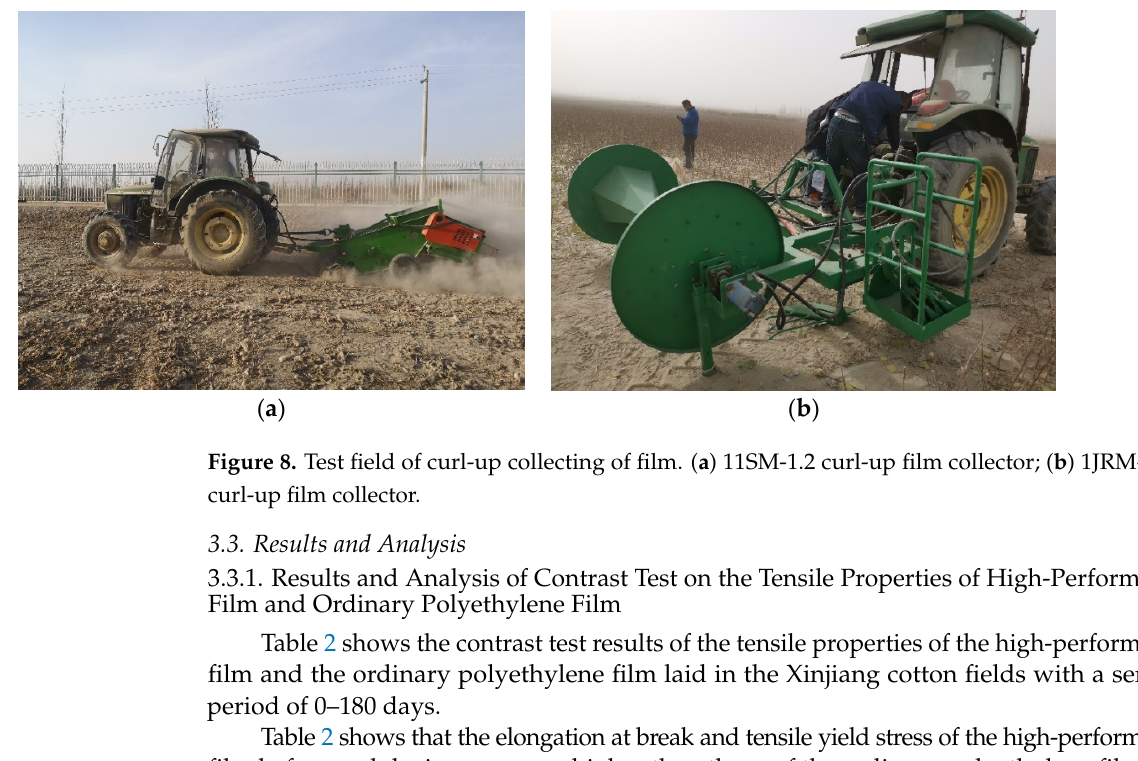
10 of 21 Figure 7. Operation process of the 1JRM ‐ 2000 curl ‐ up film collector: 1—film, 2—film ‐ curling mech ‐ anism, 3—film pick ‐ up mechanism, 4—operation platform, 5—body frame, 6—traction mechanism, 7—deep limiter, 8—soil. During operation, the variation range of the film pick ‐ up angle is α 1 ‐α 2 . According to Figure 8, during the operation process of the curl ‐ up film collector, the collected residue film would continually wrap around the film ‐ curling device, increasing the film pick ‐ up angle with the increase in the diameter of the residue film wrapping around the film ‐ curling device. The HP ‐ 50 digital display pull ‐ and push ‐ strength calculator was adopted to measure the curl ‐ up force. During the force measurement, one end of the film was con ‐ nected with the pull and push strength calculator, and the other end was at different an ‐ gles with the ground to simulate the changing process of film pick ‐ up angle during the curl ‐ up collecting of film. The value of the film pick ‐ up angle is controlled by the digital display angle ruler. When the film is initially pulled up, the soil on the film accumulates,